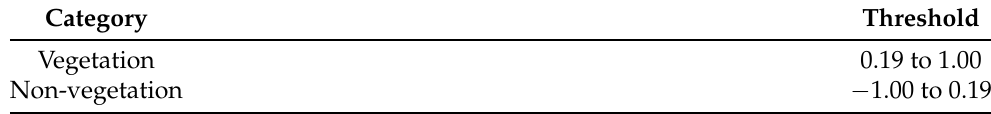
Table 2. Level-1 classification of LGA into two broad regions: non-vegetation and